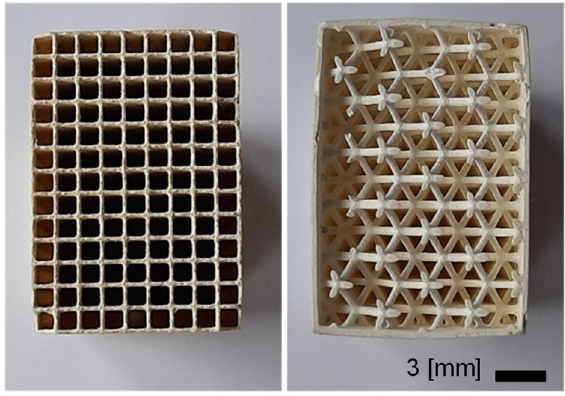
Figure 7. ( left ): washcoated cordierite honeycomb (M1); ( right ): washcoated 3D-printed alumina lattice.